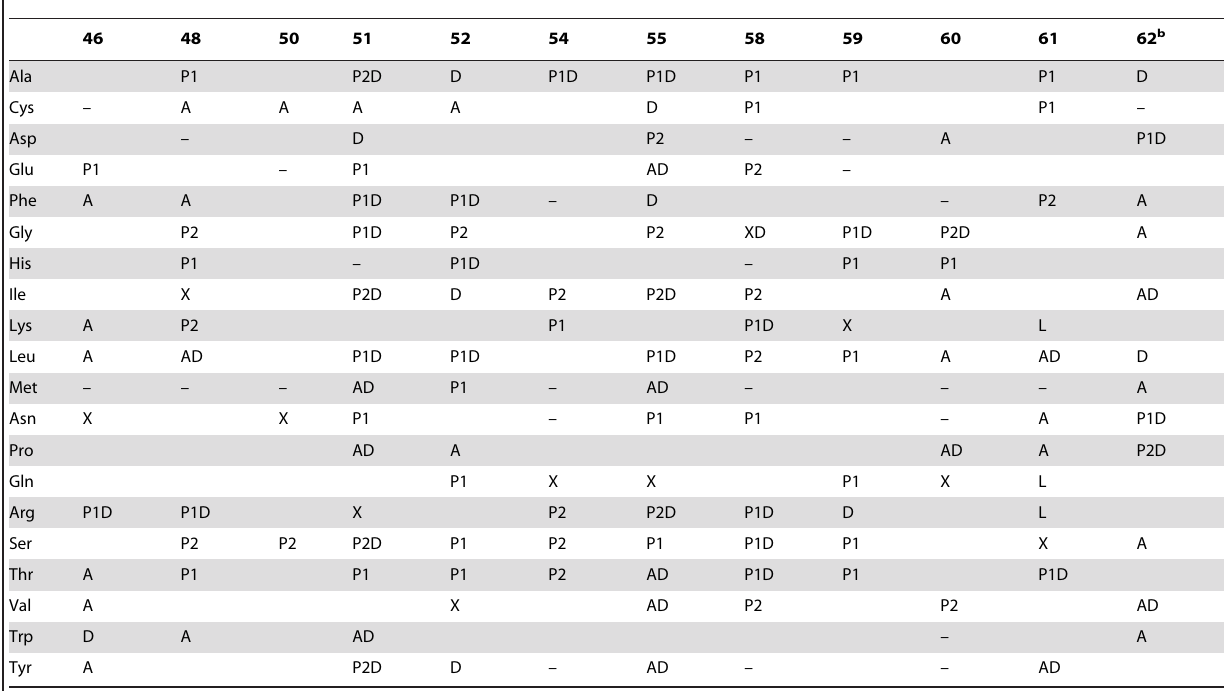
Table 5. MSA frequency versus substitution outcome and results from parallel mutagenesis a